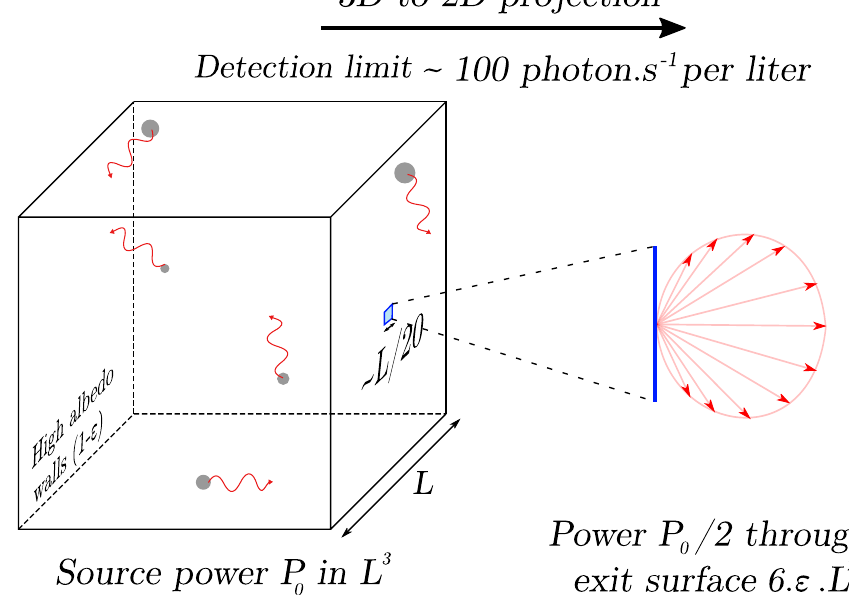
Figure 1. Optical projection and concentration from 3D to 2D. Stochastic conjugation of an extended 3D light source with a 2D emitter, using an Ulbricht (or integrating) cavity with diffuse reflective walls, and with a small exit orifice that act as a secondary Lambertian emitter. Optimal detection with a 2D detector coupled to the orifice is obtained when the ratio of the orifice area to the walls area equals the reflection loss coefficient ǫ ρ , whereby 50% of the photons produced inside will exit the cavity. For a cubic emitter of with a 1 = − volume L 3 and a square orifice l 2 , the linear size of the 3D cavity is reduced to the linear size of the 2D orifice by √ 6 ǫ , which can reach 1 / 20 the factor l / L =